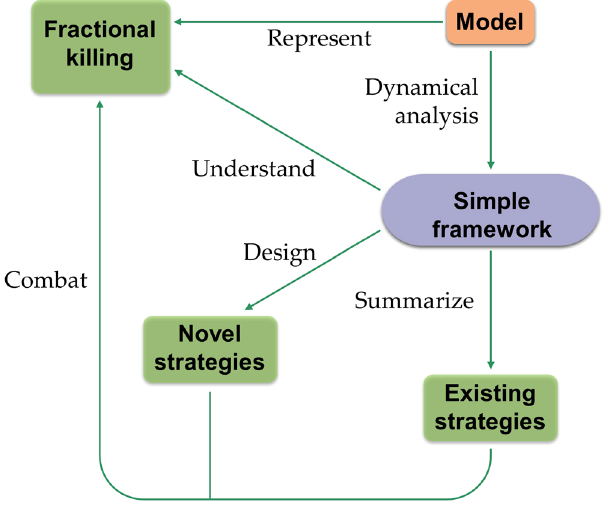
Figure 7. In order to understand fractional killing, a representative model is constructed and analyzed. Analysis of the model reveals a simple dynamical framework, which both explains the existing strategies and helps to design novel strategies that combat fractional killing. See discussion for elaboration.